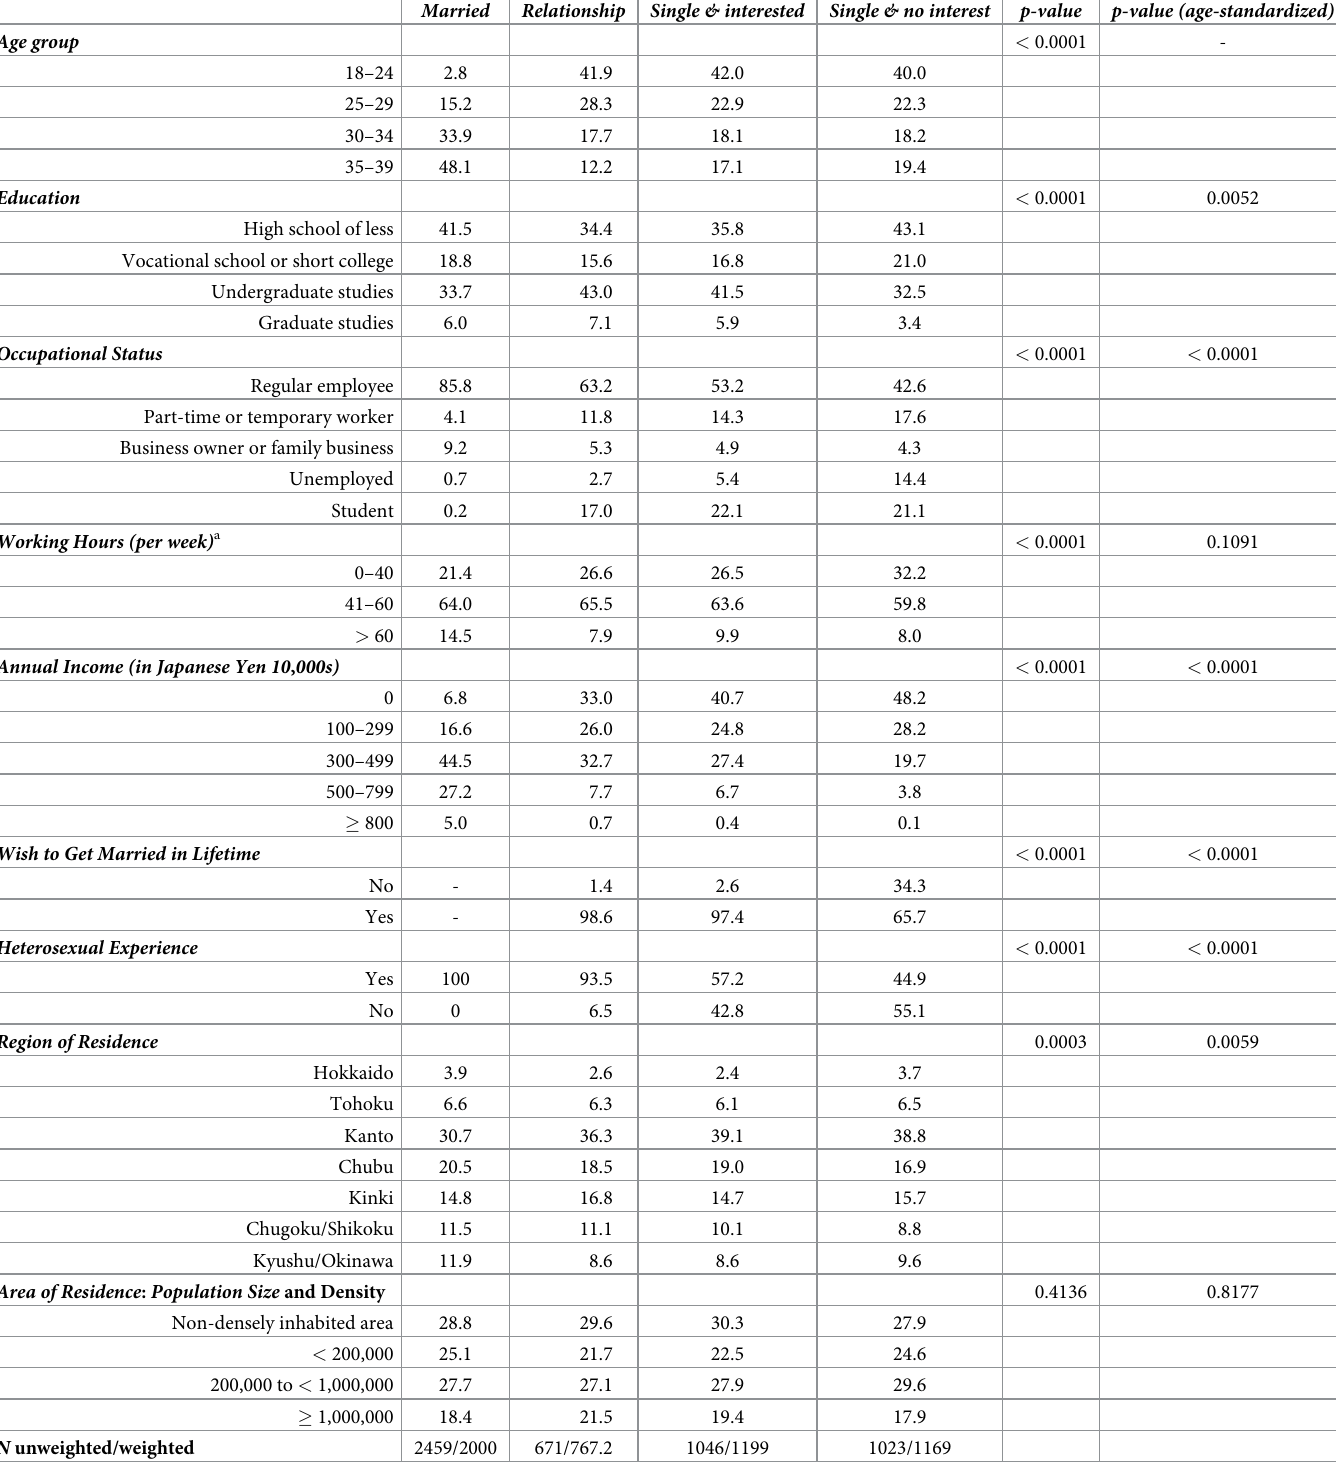
Table 2. Weighted population characteristics of men by heterosexual relationship status and interest in romantic relationships in 2015. Numbers are shown in percent.